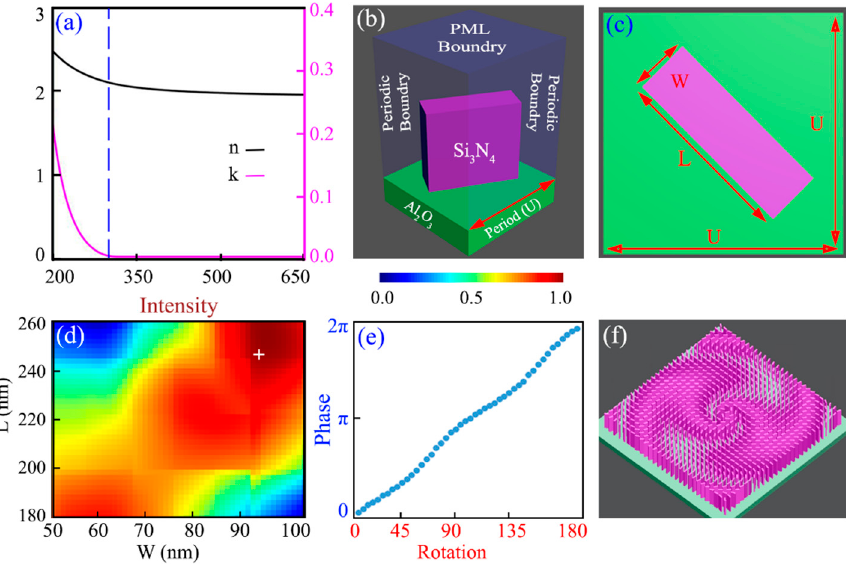
Figure 2. Material properties and parametric optimization of the unit cell. ( a ) Ellipsometry data of the engineered silicon nitride material deposited using plasma-enhanced chemical vapor deposition (PECVD) under different gas ratios of SiH4:N2. Presented dielectric material exhibits negligible absorption loss k = 0.00011 at the ultraviolet wavelengths. ( b ) Schematic illustration of the simulated fundamental building block where the rectangular-shaped nanoantenna of Si 3 N 4 sitting on the sapphire substrate is used for parametric analysis. Finite difference time domain-based FDTD Solution software is used to perform the optimization, where periodic boundary conditions are applied along the x- and y-axes, and PML boundaries are applied along the z -axis. ( c ) The top view of the unit cell consists of a rectangular bar of Si 3 N 4 of the sapphire substrate. Here, U presents the period of the unit cell, L and W indicates the length and width of the nanoantenna, respectively. Numerical optimization of the unit cell reveals the optimized values as U = 280 nm, L = 240 nm, and W = 92 nm. ( d ) The numerically simulated transmission intensity distribution of the diffracted cross-polarized light for wavelength λ d = 300 nm. To obtain the optimized value of the nanoantenna, its length and width are swept in the software. The “+” sign on the ( d ) plot indicates the selected dimensions of the nanoantenna as mentioned above. ( e ) Verification of the nanoantenna to act as a halfwave plate. Nanoantenna is in-plane rotated and the diffracted with the opposite handedness is received and analyzed for complete phase coverage. ( f ) Schematic diagram of the designed UV metasurface with topological charge n = 2 for PV beam